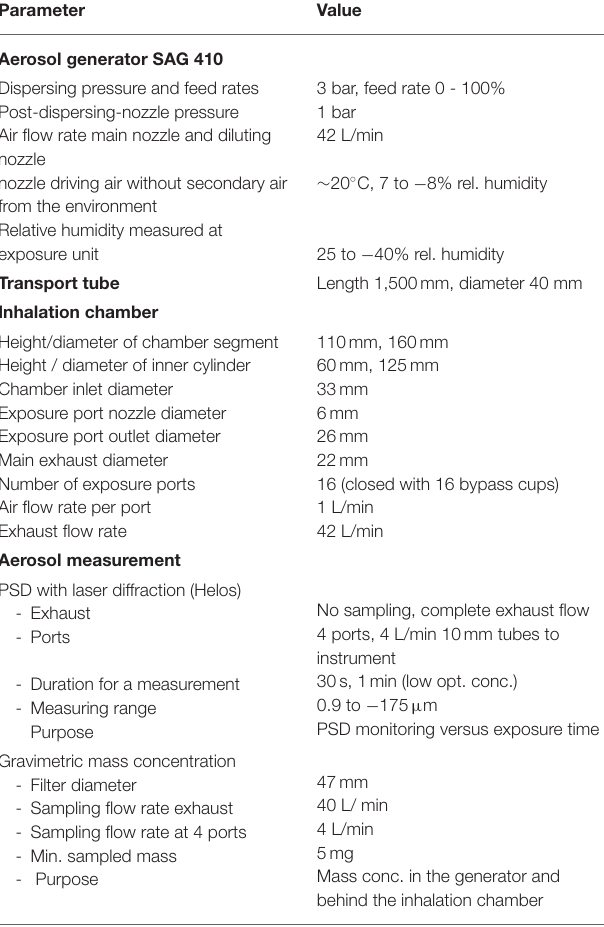
TABLE 1 | Parameters of the test apparatus. Parameter Value Aerosol generator SAG